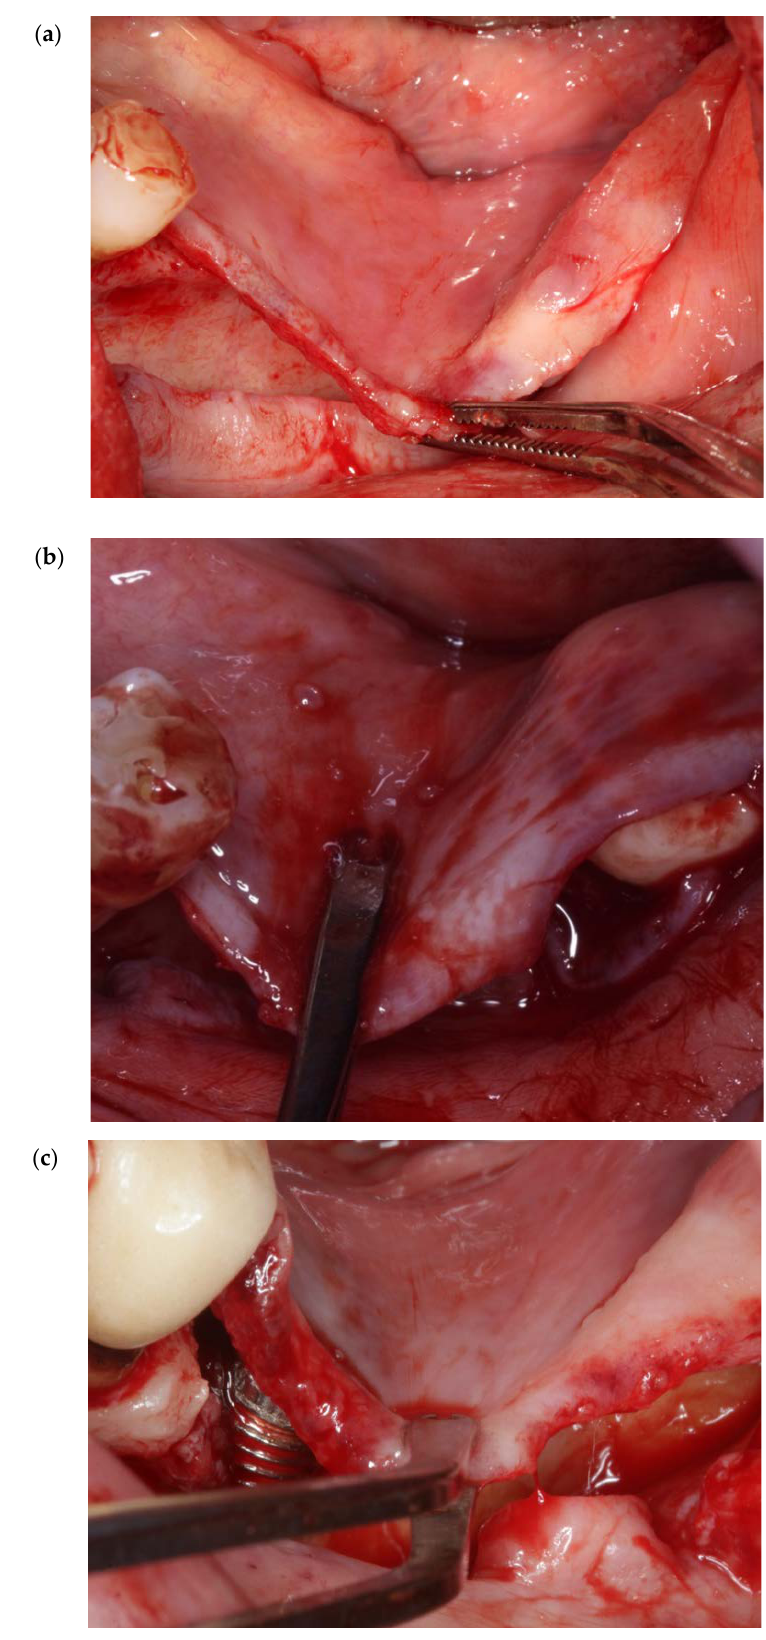
Figure 7. ( a – c ) Six to ten (6–10) mm of MMR in a horizontal direction.